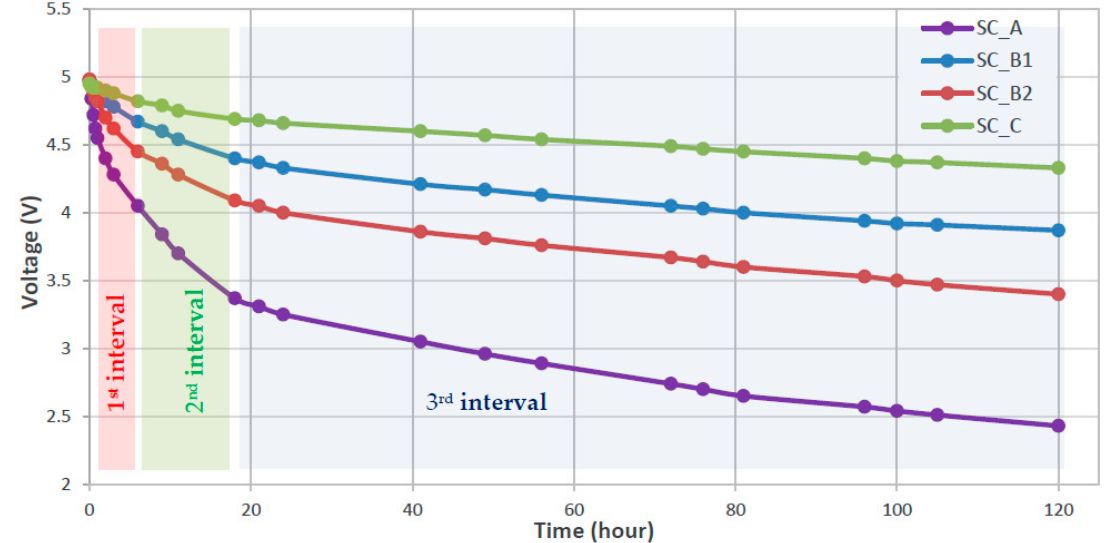
Figure 8. Self-discharge time-domain trends for two different type-B SCs (indicated as SC_B1 and SC_B2), a type-A SC (SC_A) and a 2 F type-C SC (indicated as SC_C), charged at 5 V and kept under